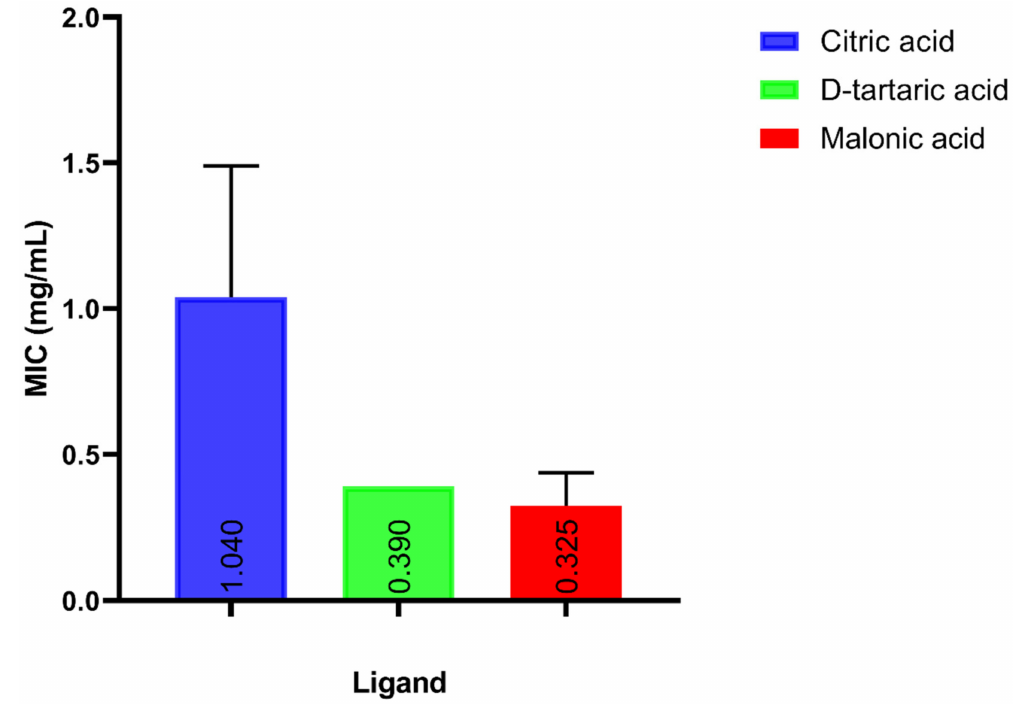
Figure 3. A bar chart representing the testing of the in vitro anti-acinetobacter activity of candidate ligands. The MIC of candidate ligands against A. baumannii ATCC 19606 was determined using the broth micro-dilution method. MIC values represent the mean of experimental triplicates. Error bars represent SD values.